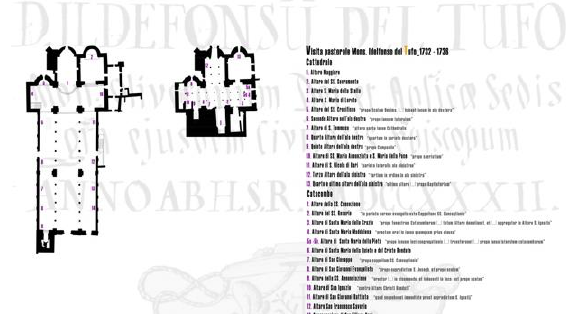
Figure 2. Hypothesis of the original placement of the